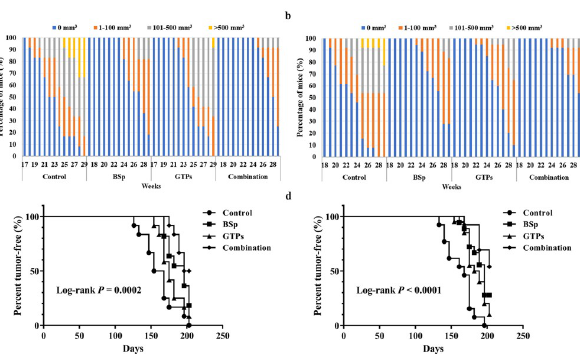
Fig 2. Tumor growth comparisons between control, BSp, GTPs and combination-fed mice dietary groups. Female Her2/neu mice were monitored for tumor growth weekly. The delay in tumor growth volume and the percentage over the whole population in BSp, GTPs and combination dietary regimens as compared to control in the BE group (a) and in the LC group (b) as shown. Colors in (a) and (b) indicate different tumor volume ranges as shown in the legend above the graph. Tumor-free survival curves for cases classified in four dietary treatments of the BE group (c) and the LC group (d) were calculated using the Mantel-Cox proportional model and differences were tested using the log-rank statistic. n = 16~20 in dietary treatments of the BE group and n = 15~20 in dietary treatments of the LC group. Tumor growth was evaluated with Bonferroni adjustment for multiple comparisons between the dietary treatment groups (80% power, significance level of 0.01, alpha = 0.05 with Bonferroni adjustment for 4 comparisons).